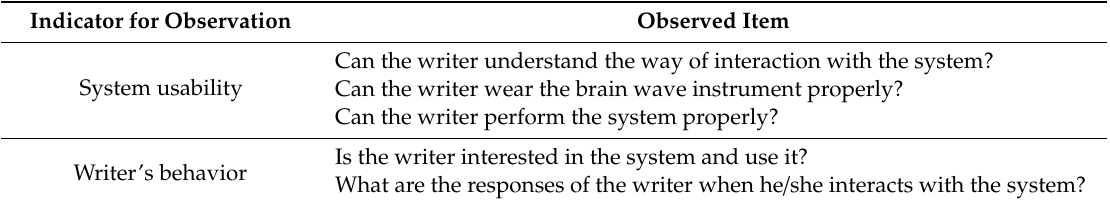
Table 5. List of items for observations of the two indicators of system usability and writer’s behavior. Indicator for